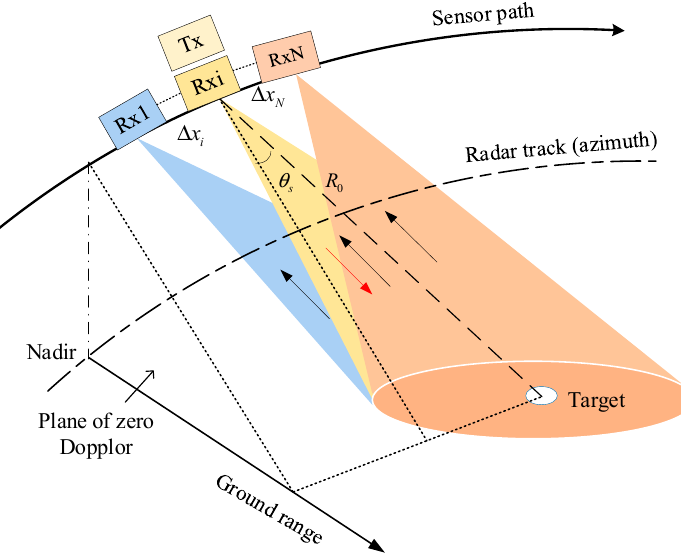
Figure 2. The observation geometry in spaceborne azimuth multichannel squinted SAR.